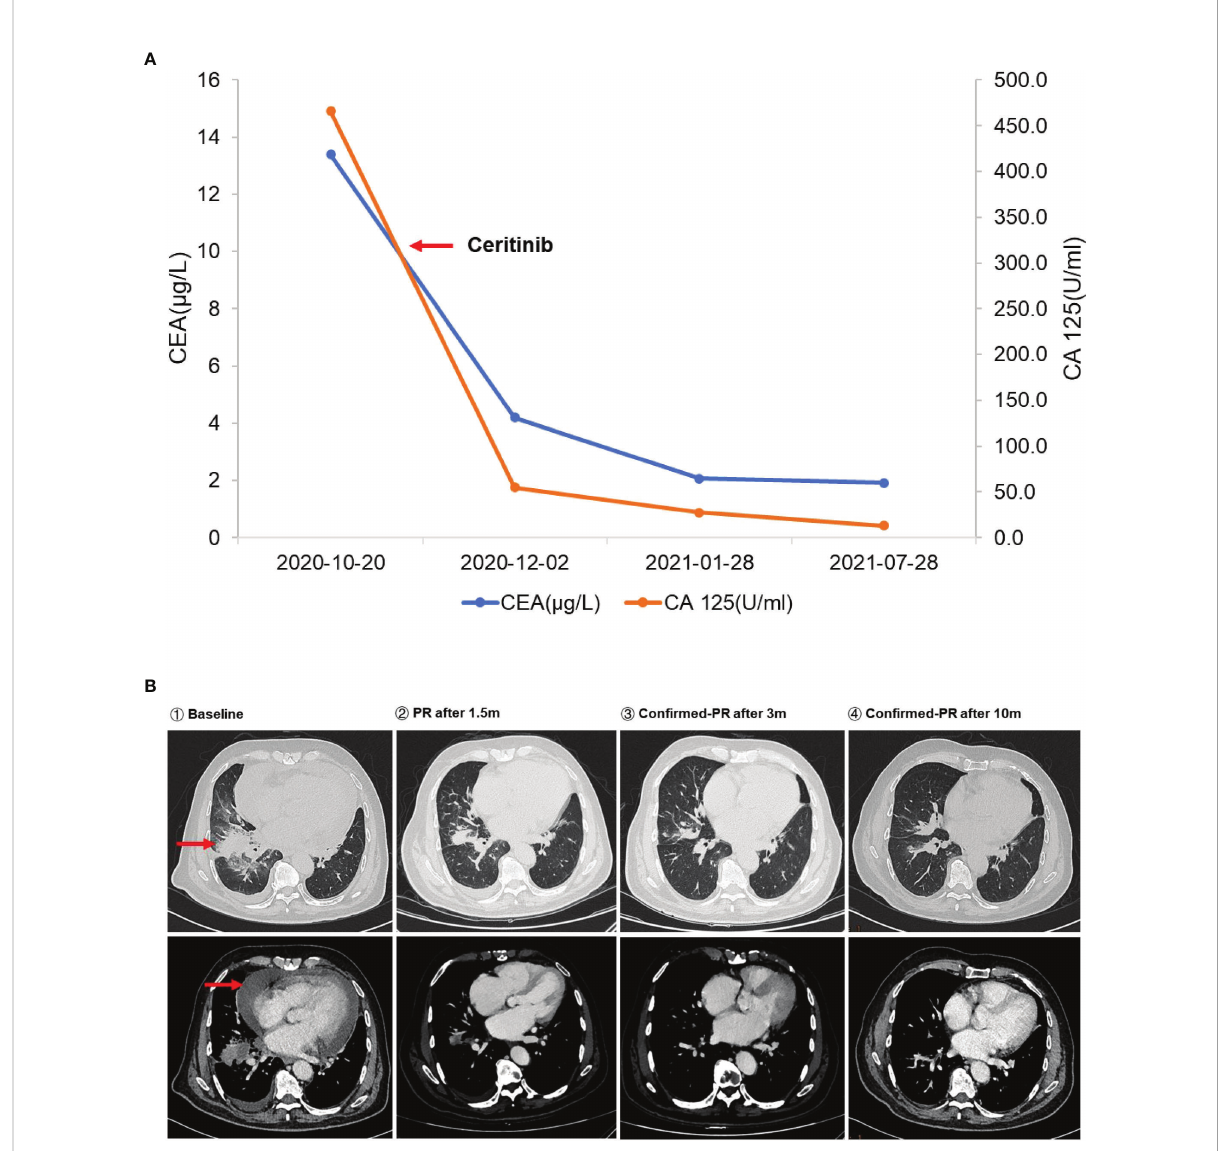
FIGURE 2 (A) The changes in serum carcinoembryonic antigen (CEA) and CA 125 level during ceritinib treatment. The left red arrow means initiation of ceritinib. (B) Dynamic imaging of lung lesions at different stages of treatment. The red arrows indicate the baseline lesion and pericardial